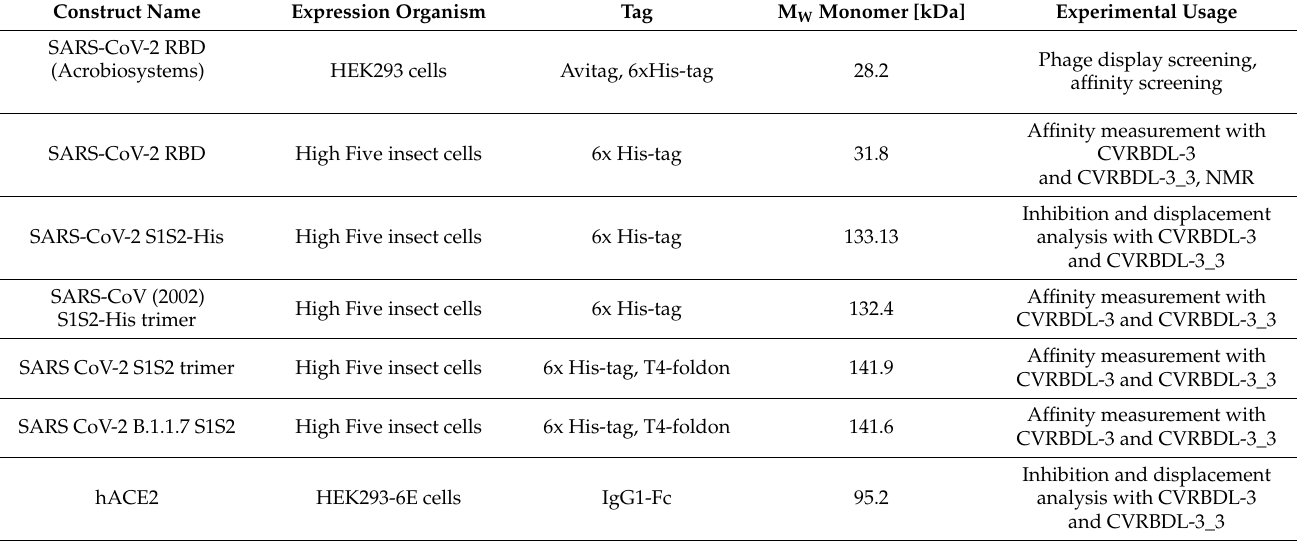
Table A1. SARS-CoV, SARS-CoV-2 spike protein and hACE2 constructs used in the study including organism used for expression, introduced tags for multimerization and purification, molecular weight (MW) and experimental